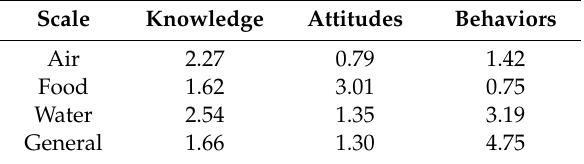
Table 4. Eigenvalues of retained factors for Air, Food, Water and General environmental health